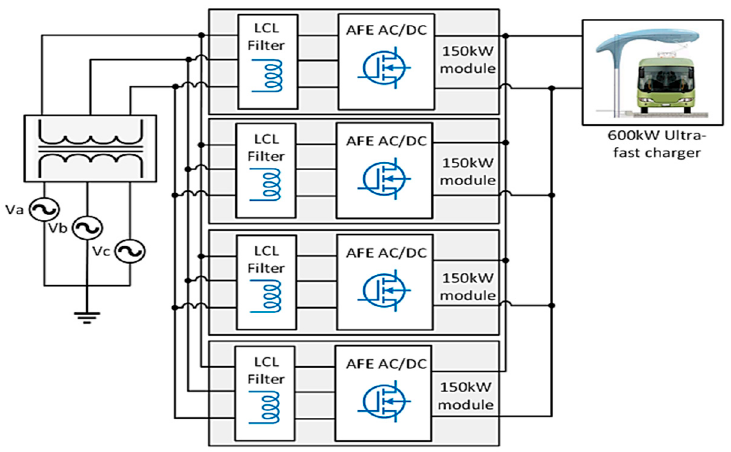
Figure 6. GaN-switch-based bidirectional OBC system topologies [107].